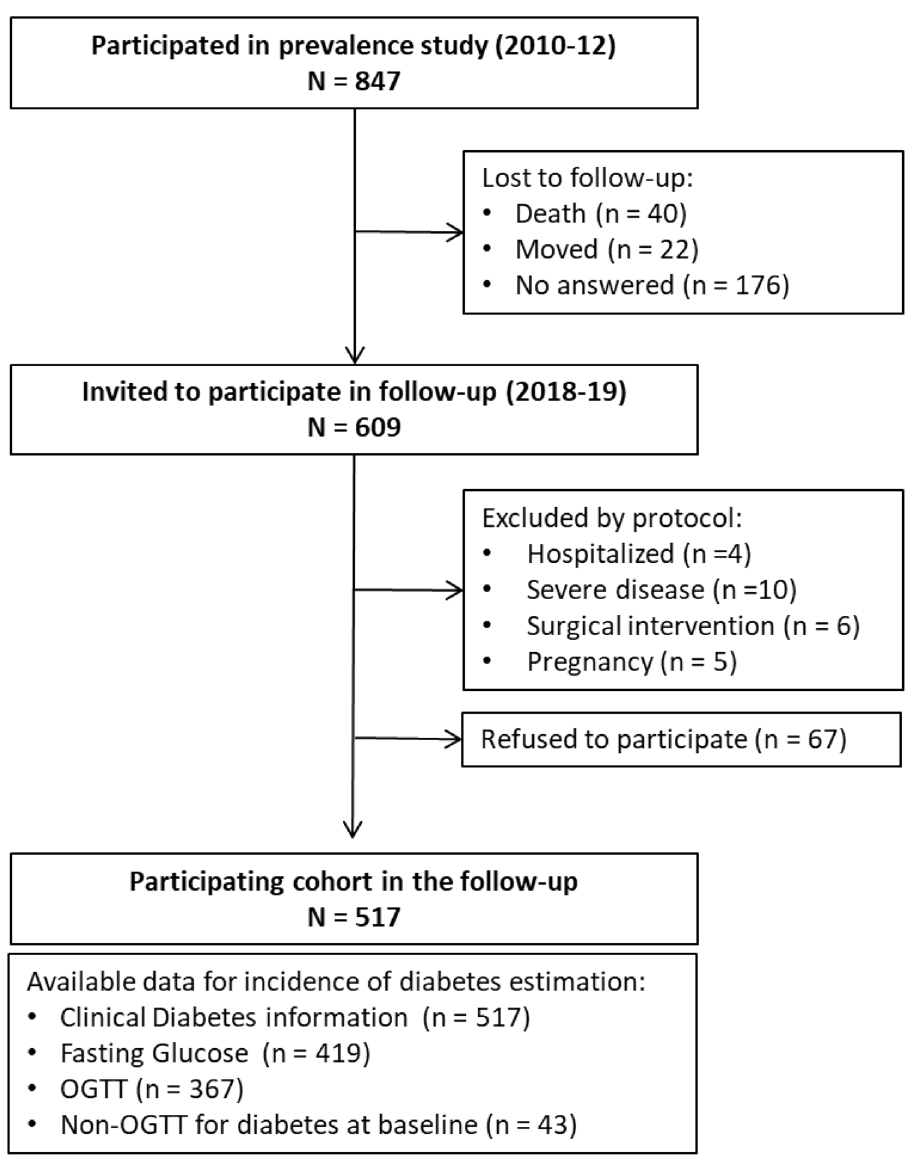
Figure 1. Participation flow